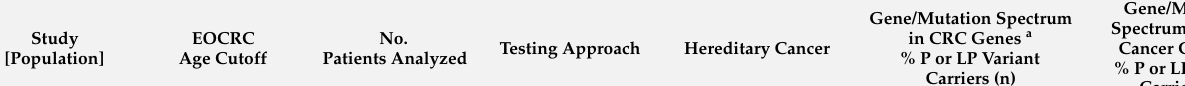
Table 1. Prevalence of germline pathogenic variants in hereditary cancer genes among early-onset colorectal cancer (EOCRC) patients. Studies including >100 EOCRC patients and analyzing multiple (>10) hereditary cancer genes or whole exomes are listed in the